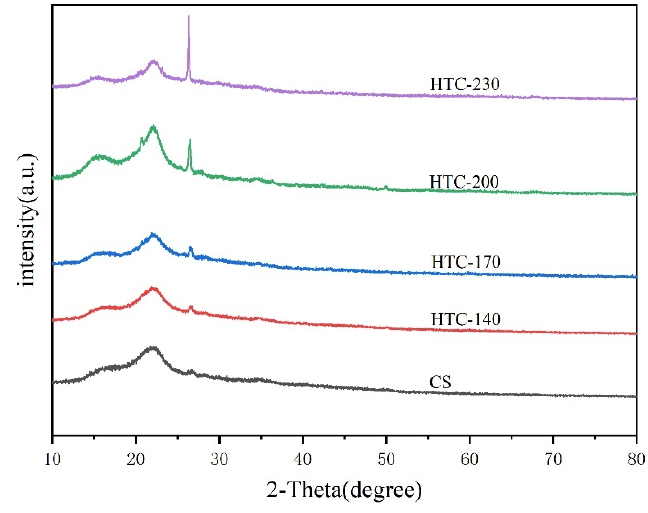
Figure 3. XRD patterns of CS and hydrochar.